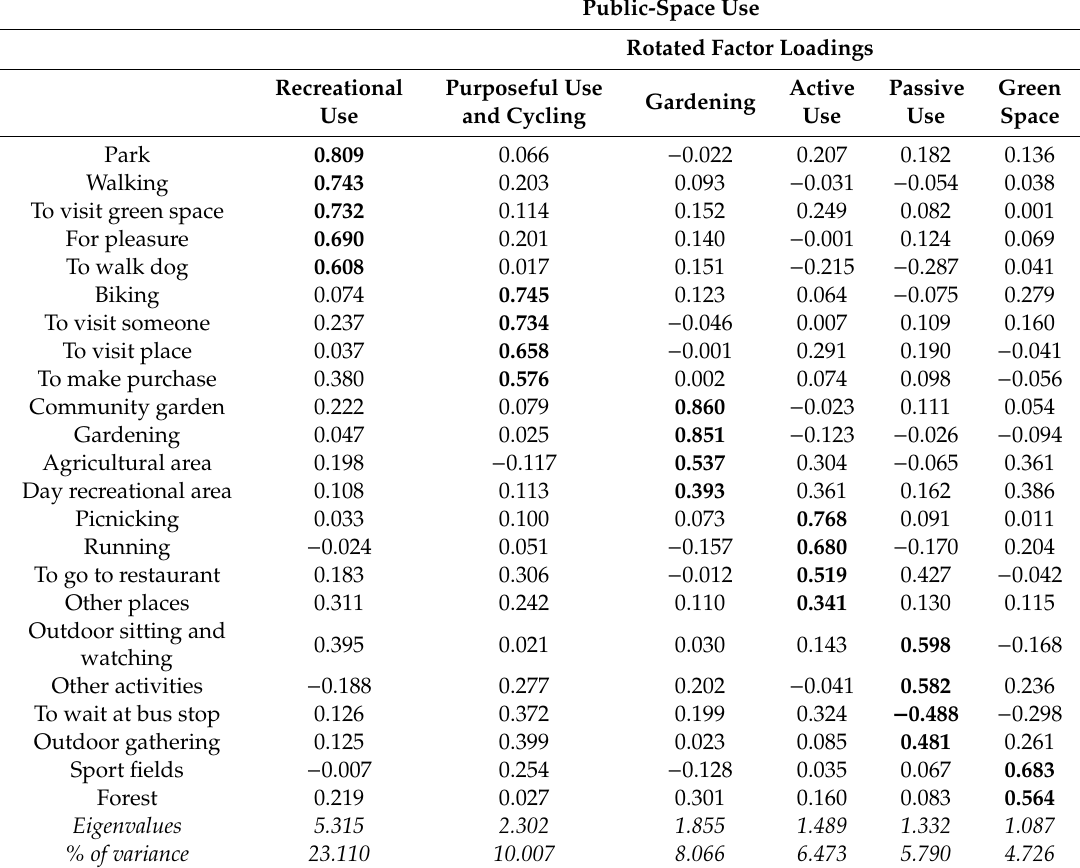
Table A1. Principal component analysis of public-space